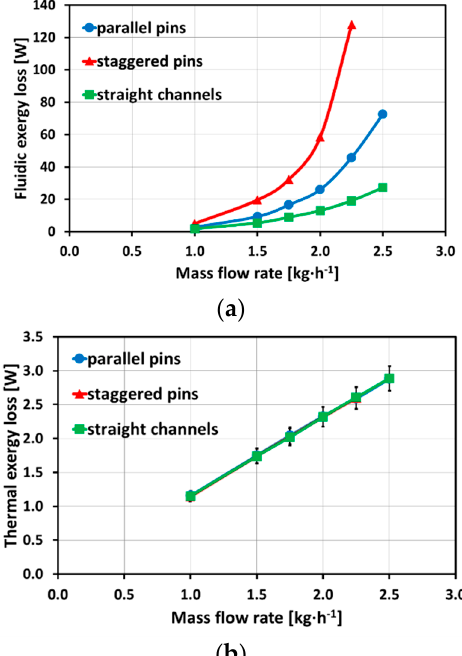
Figure 11. Fluidic exergy loss ( a ) and thermal exergy loss ( b ) for different microstructures (with a maximum uncertainty of fluidic exergy loss of Δ ( Δ E P ) = ±1.2 W and a maximum uncertainty of thermal exergy loss of Δ ( Δ E T ) = ±0.2 W).